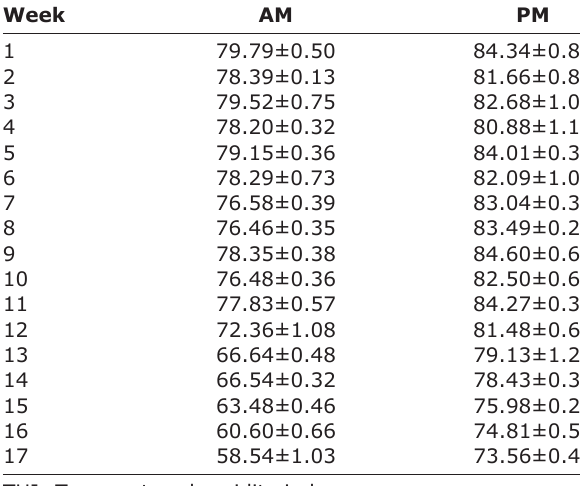
Table-2: THI values for the morning (AM) and afternoon (PM) during experimental period.